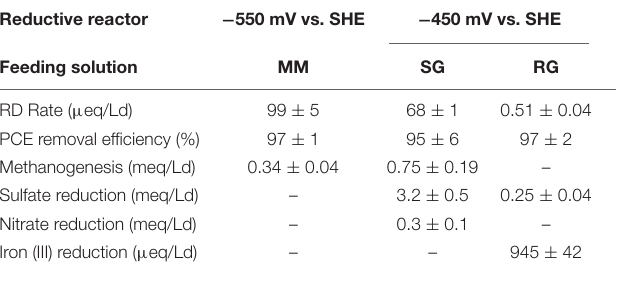
TABLE 4 | Reductive reactor performances with the three feeding solutions: Mineral Medium (MM), Synthetic groundwater (SG), and Real Groundwater (RG). Reductive reactor − 550 mV vs. SHE − 450 mV vs. SHE Feeding solution